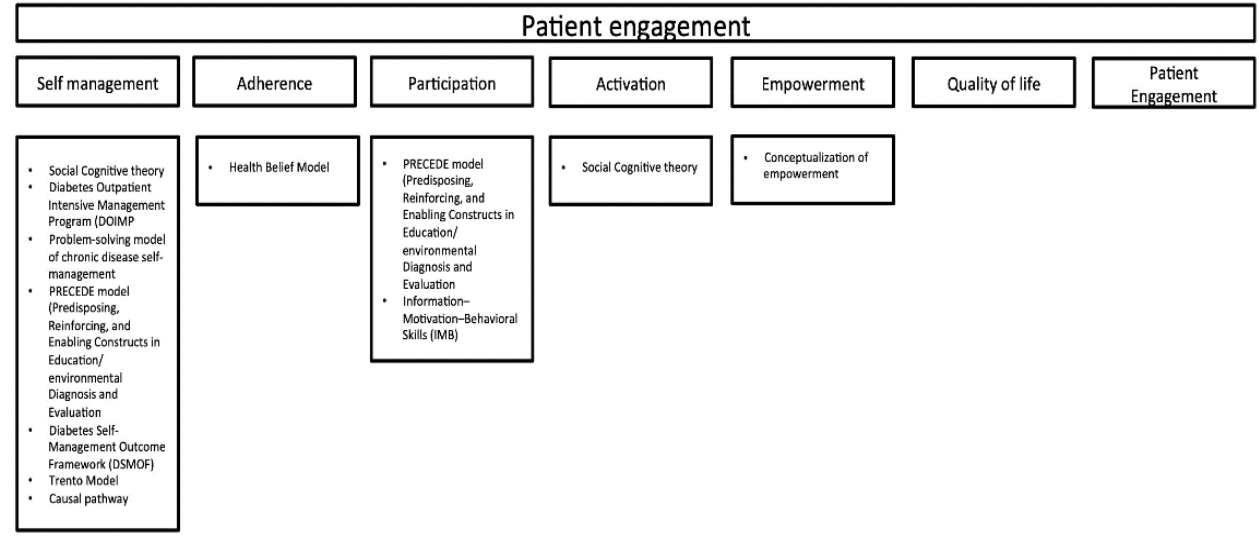
Figure 2. Graphical representation of the theoretical framework used for the different conceptualization of patient engage- ment.